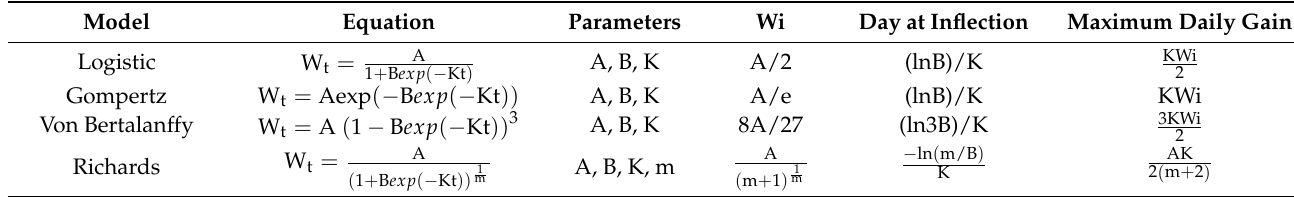
Table 1. Growth curve models adopted in the study and related